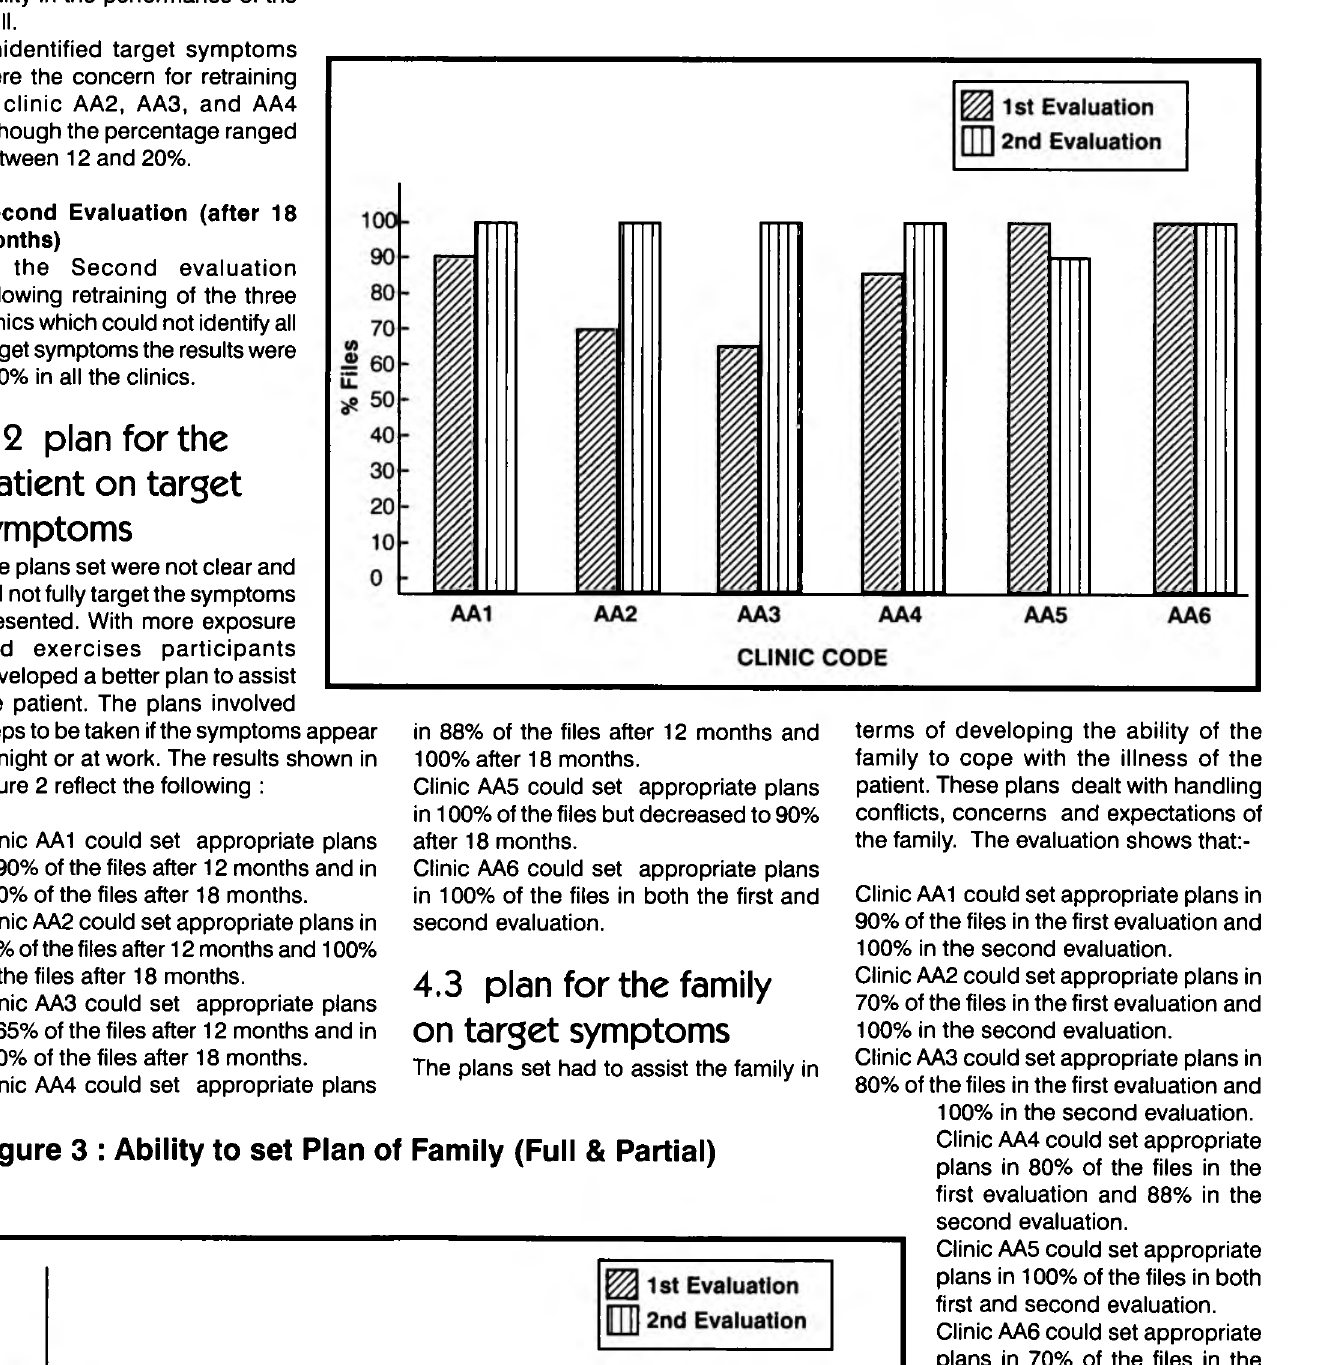
ability in the performance of the